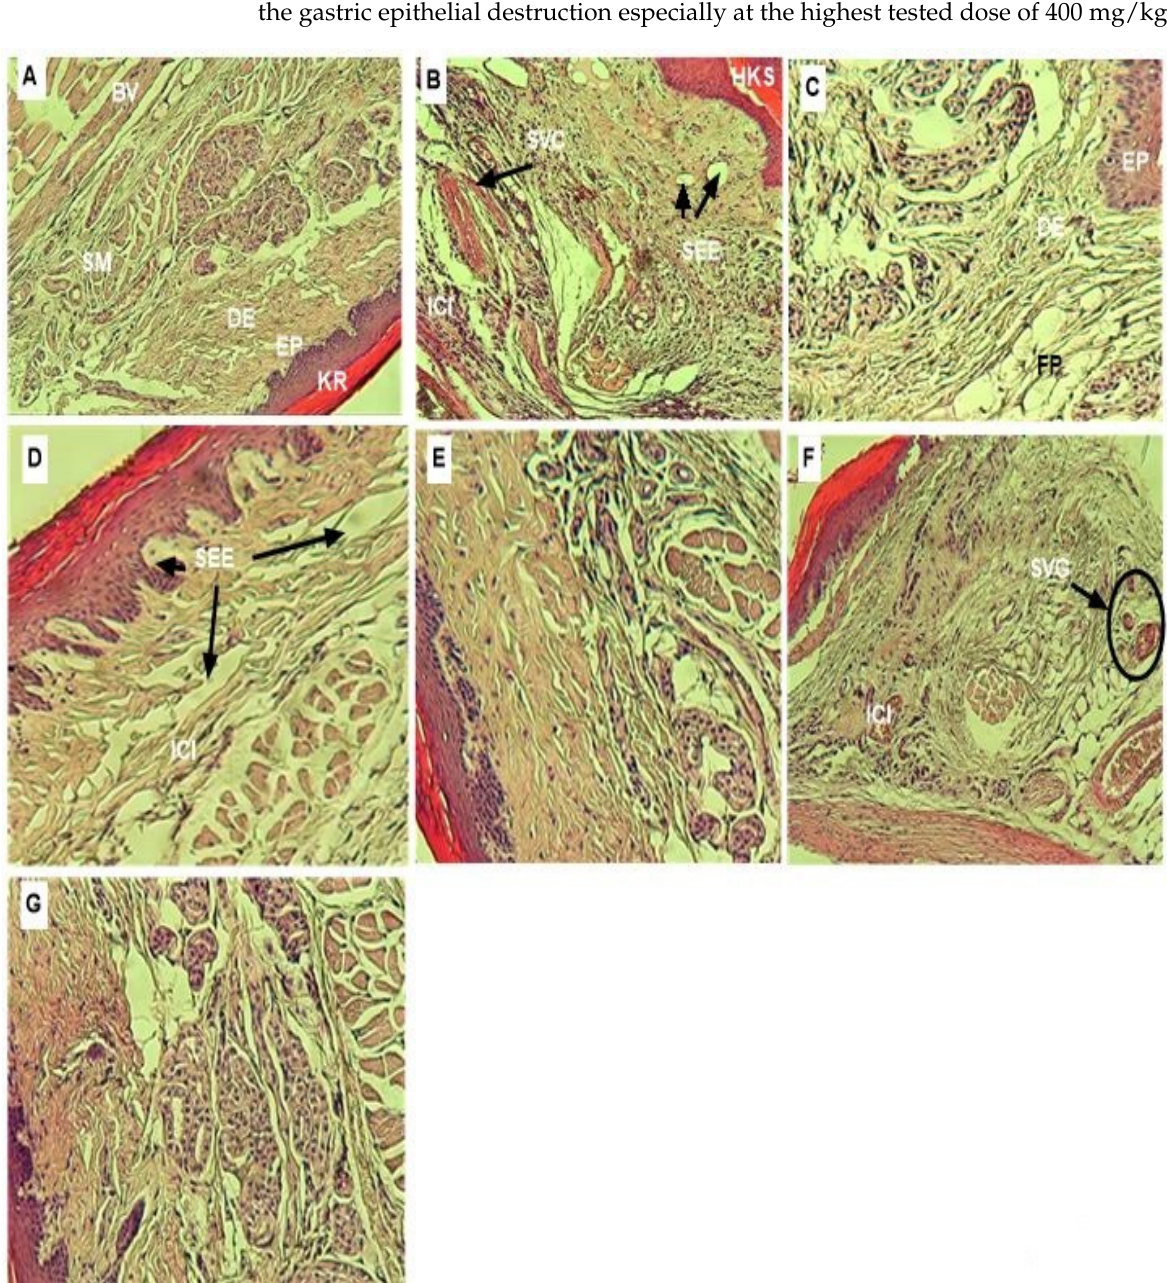
Figure 5. Histological examination of mice paws tissue in carrageenan ‐ induced paw edema model